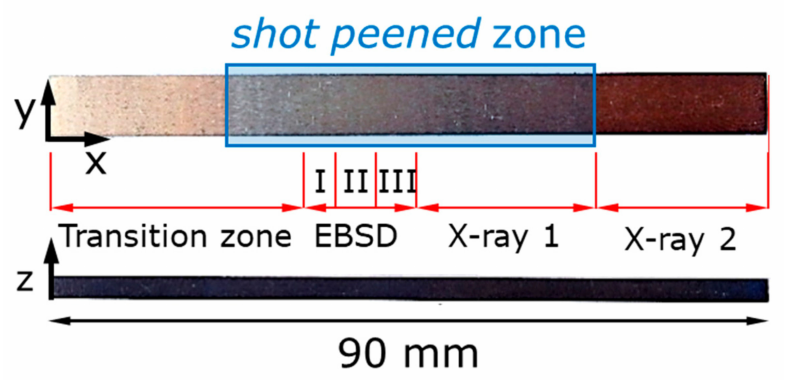
Figure 1. Initial specimen with the indicated coordinate system, dimensions, and regions of interest along which it was cut.